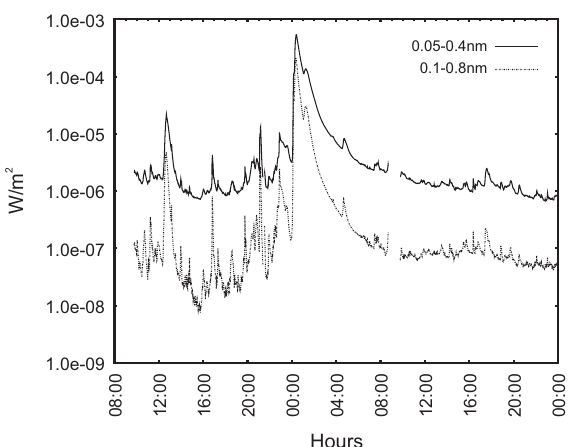
Fig. 2. GOES 15 X-Ray Flux measurement from 08:00 March 6th to 00:00 March 8th, 2012.